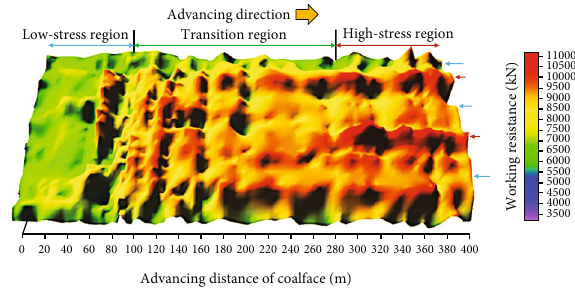
Figure 13: Distribution characteristics of the daily average working resistance of hydraulic